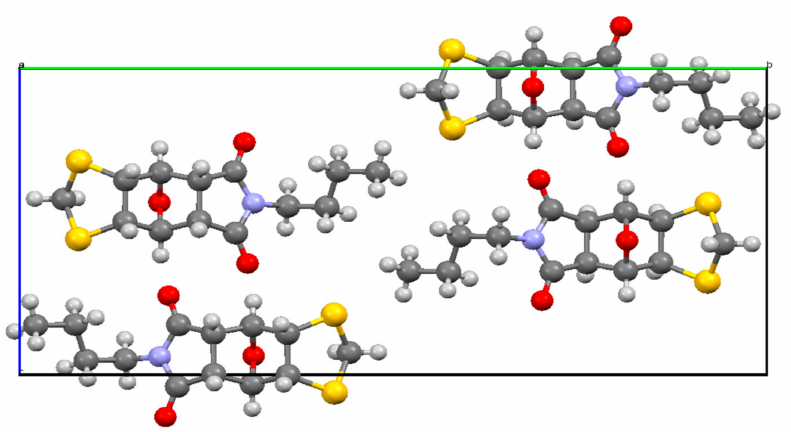
Figure 2. The unit cell of 1 viewed along the a axis showing the four molecules present in a centrosymmetric arrangement.